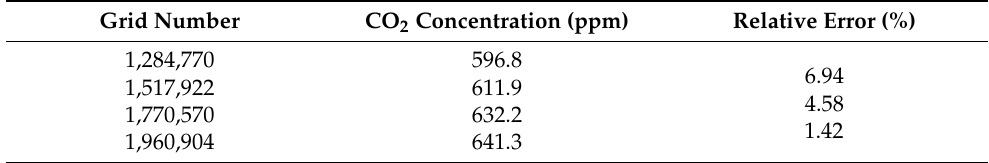
Table 4. Grid refinement